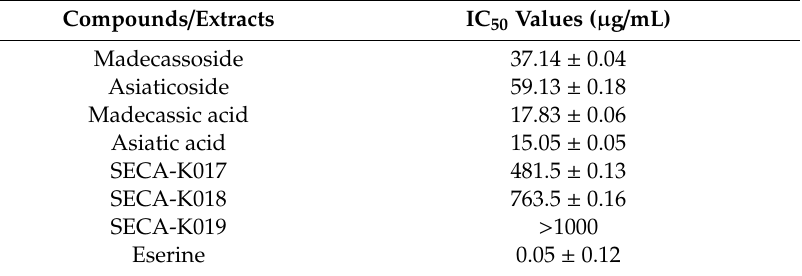
Table 4. AChE inhibitory activity of standardize triterpenes and extracts of CA